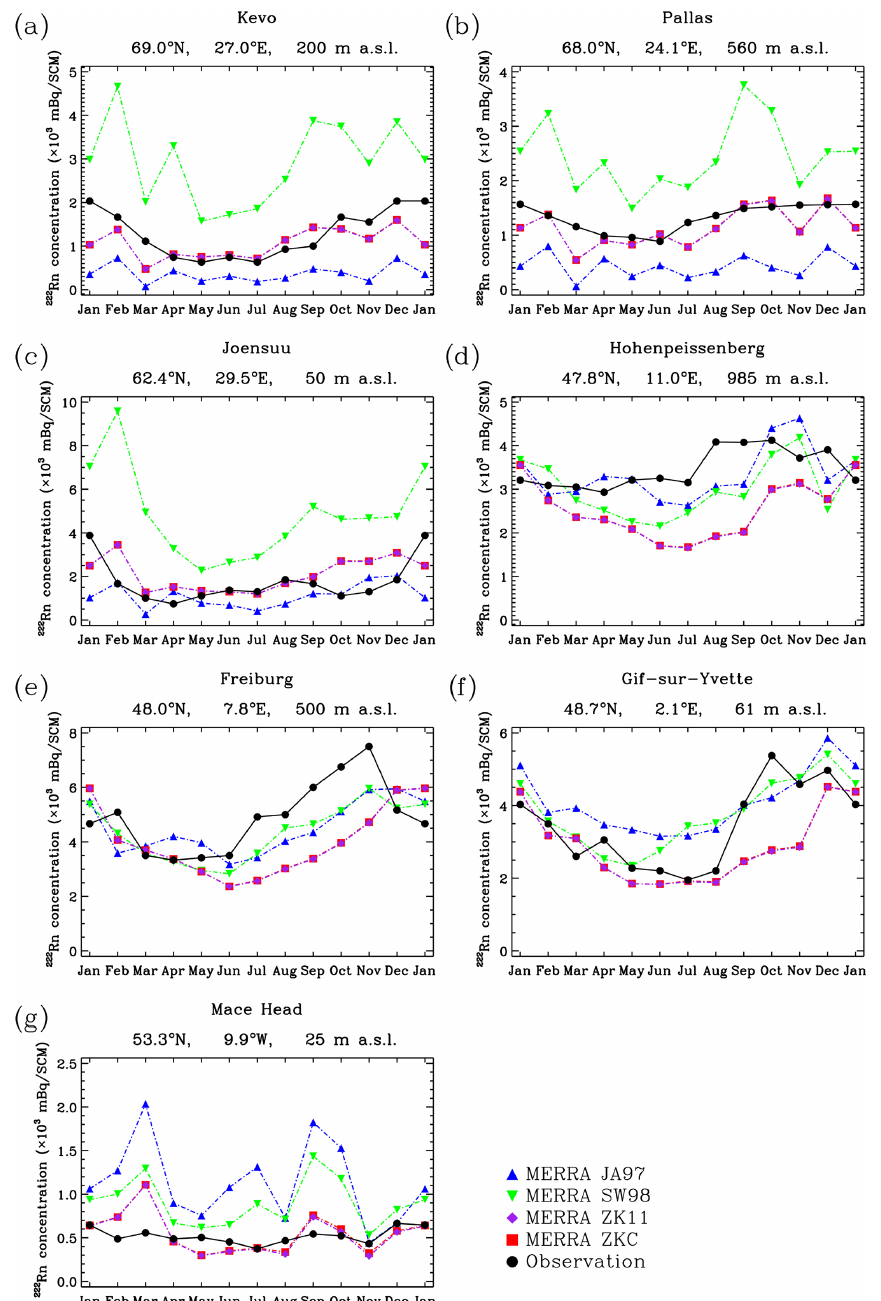
Figure 8. Comparison between observed 222 Rn climatological monthly means (black lines) and simulated monthly means in 2013 (colored lines) at selected surface sites in Europe. Location and elevation of each site are given above each panel. See Table 2 for the list of model simulations. Note the small difference between the simulations with ZK11 and those with ZKC because of identical 222 Rn emission in